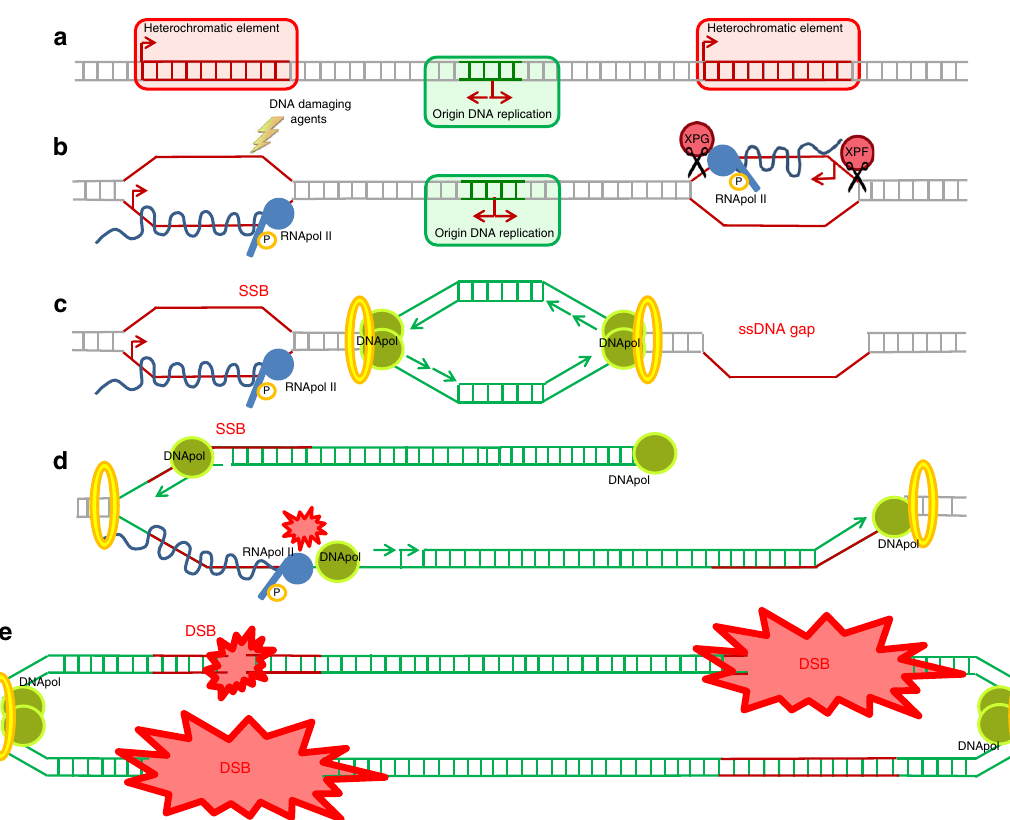
Fig. 9 Model for the contribution of dH1 to maintenance of genome integrity. In the absence of dH1, expression of heterochromatic elements is upregulated a , inducing the accumulation of R-loops b that could generate SSBs through targeting of the ssDNA regions by DNA-damaging agents or ssDNA gaps through processing of the DNA:RNA hybrids by the NER system b and c . During DNA replication, SSBs and ssDNA gaps are converted into DSBs d and e . Collisions with the replication machinery could also stall replication fork progression and generate DSBs d and